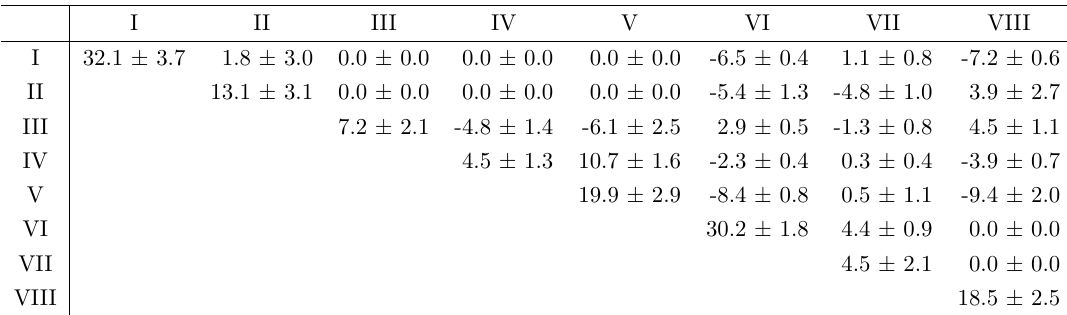
→ K + ρ 0 , s → K + f 0 (1370) , VI s